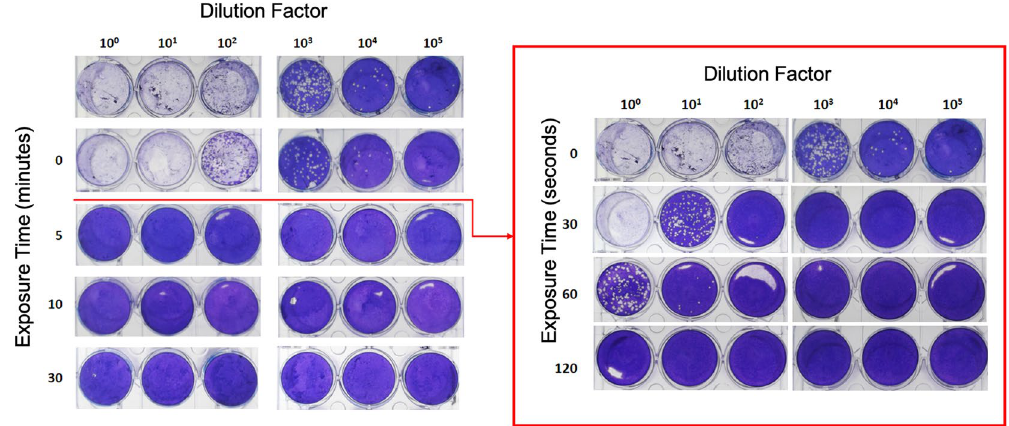
Figure 4. Representative image of cytophatic effect an viral plaque formation in samples exposed to UV-C light at the indicated times for an irradiance of ∼ 14 W/m 2 (see Irradiation chamber section). The red box on the right expands the exposure time between 0 and 2 min.